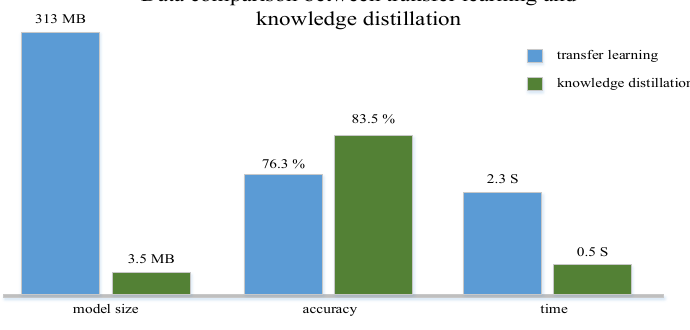
Table 6. Results of identification accuracy test.